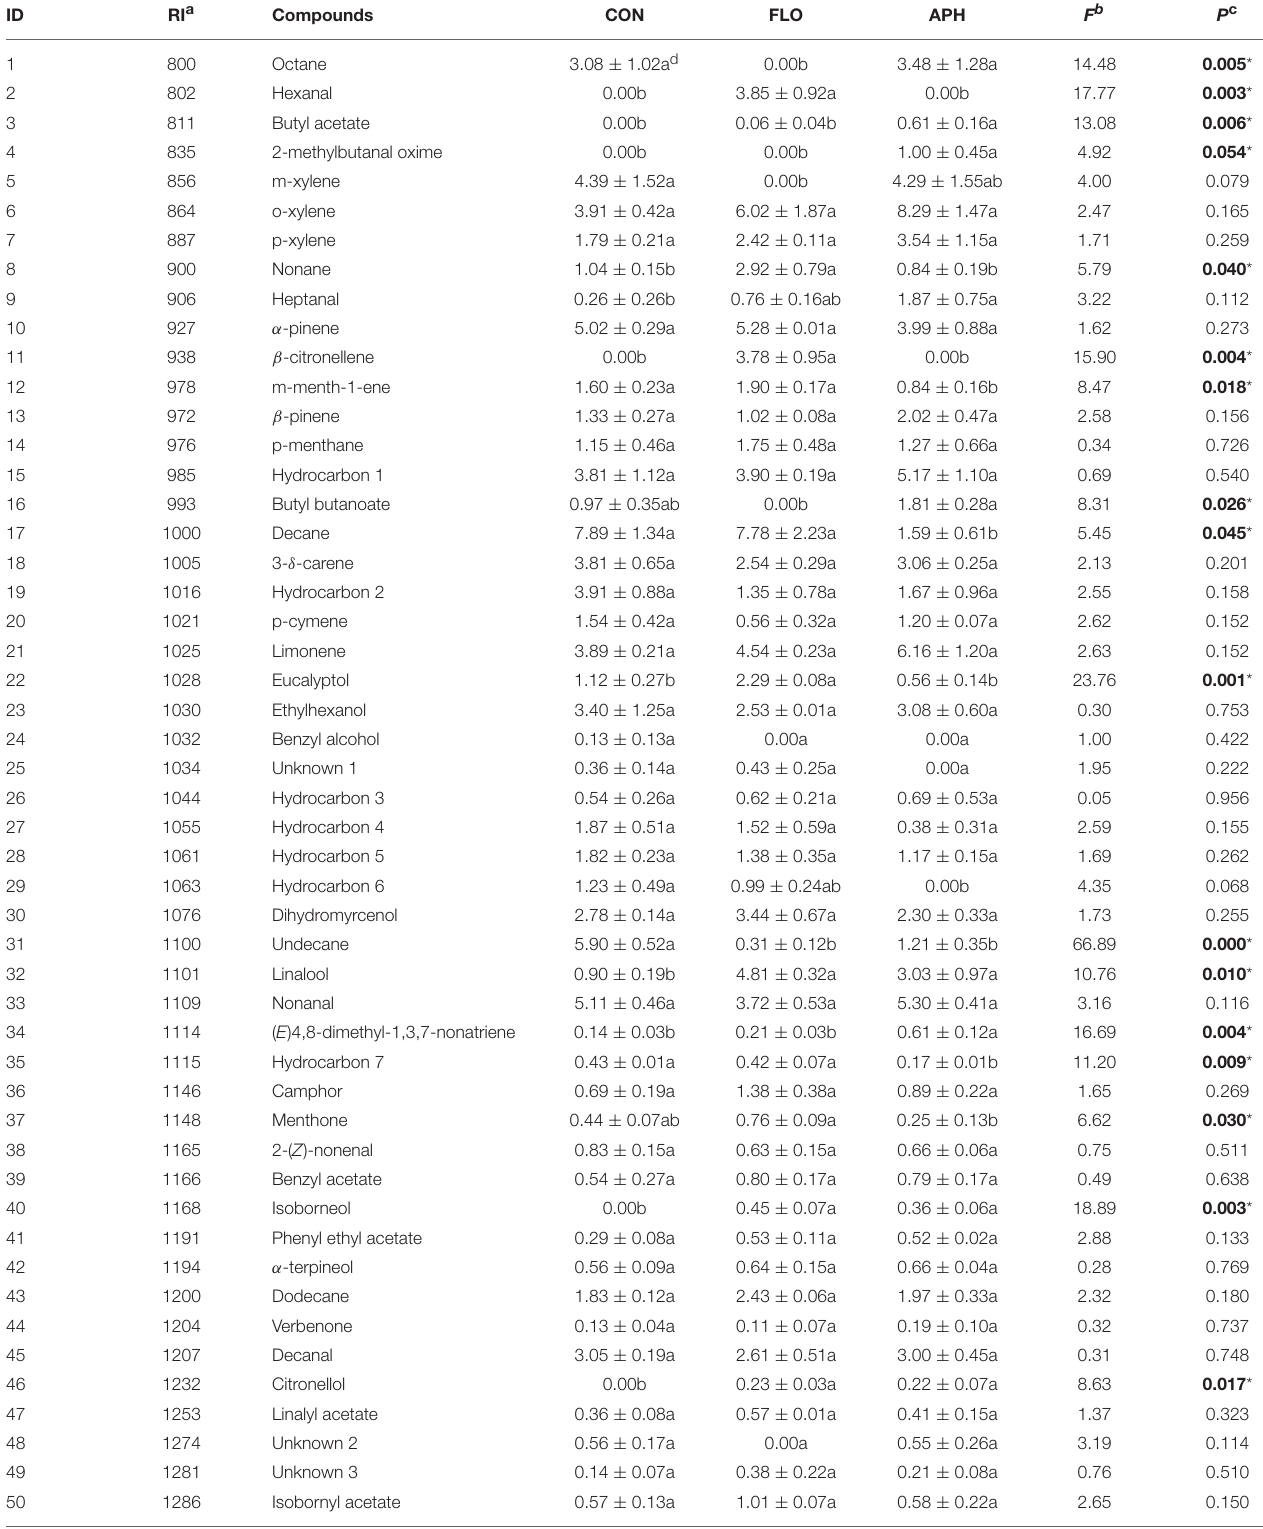
TABLE 2 | Volatile composition of headspace of uninfested (CON), flowering (FLO), and aphid infested aubergine plants (APH) expressed as total peak area (102 ± SE, n =